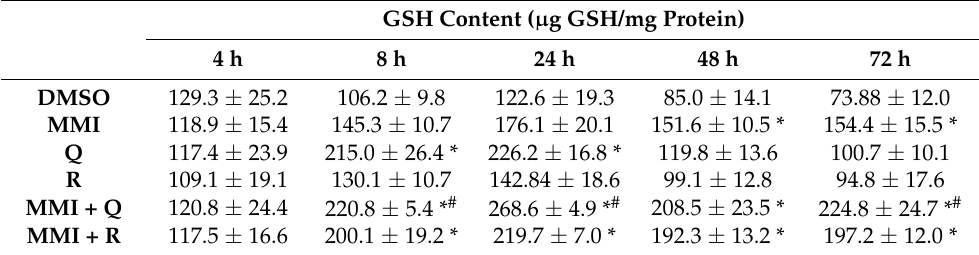
Table 2. Reduced GSH content in CRFK cells treated with MMI (4 µ M), Q (6 µ M), or R (4 µ M) or co-exposed to MMI (4 µ M) + Q (6 µ M), and MMI (4 µ M) + R (4 µ M) after 4, 8, 24, 48, and 72 h. GSH Content ( µ g GSH/mg